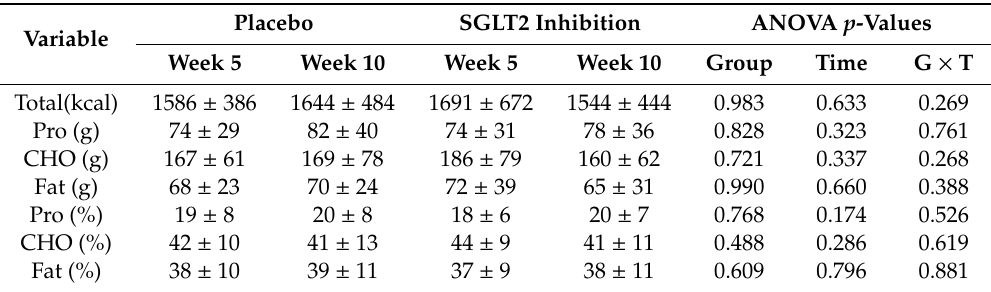
Table 2. Dietary intake following 5, and 10 weeks of dietary counselling for weight loss supplemented with placebo or SGLT2 inhibition.